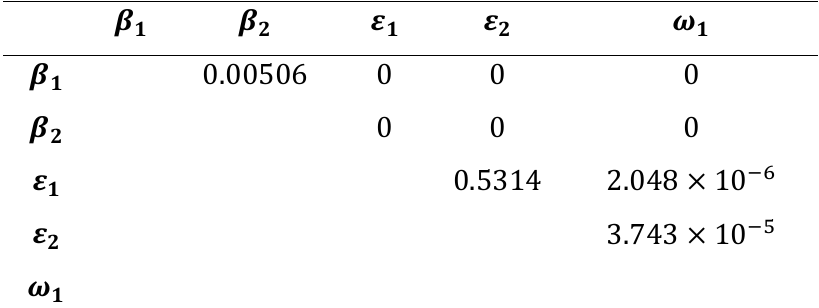
Table 3. Pairwise PRCC Comparisons (unadjusted p-values)